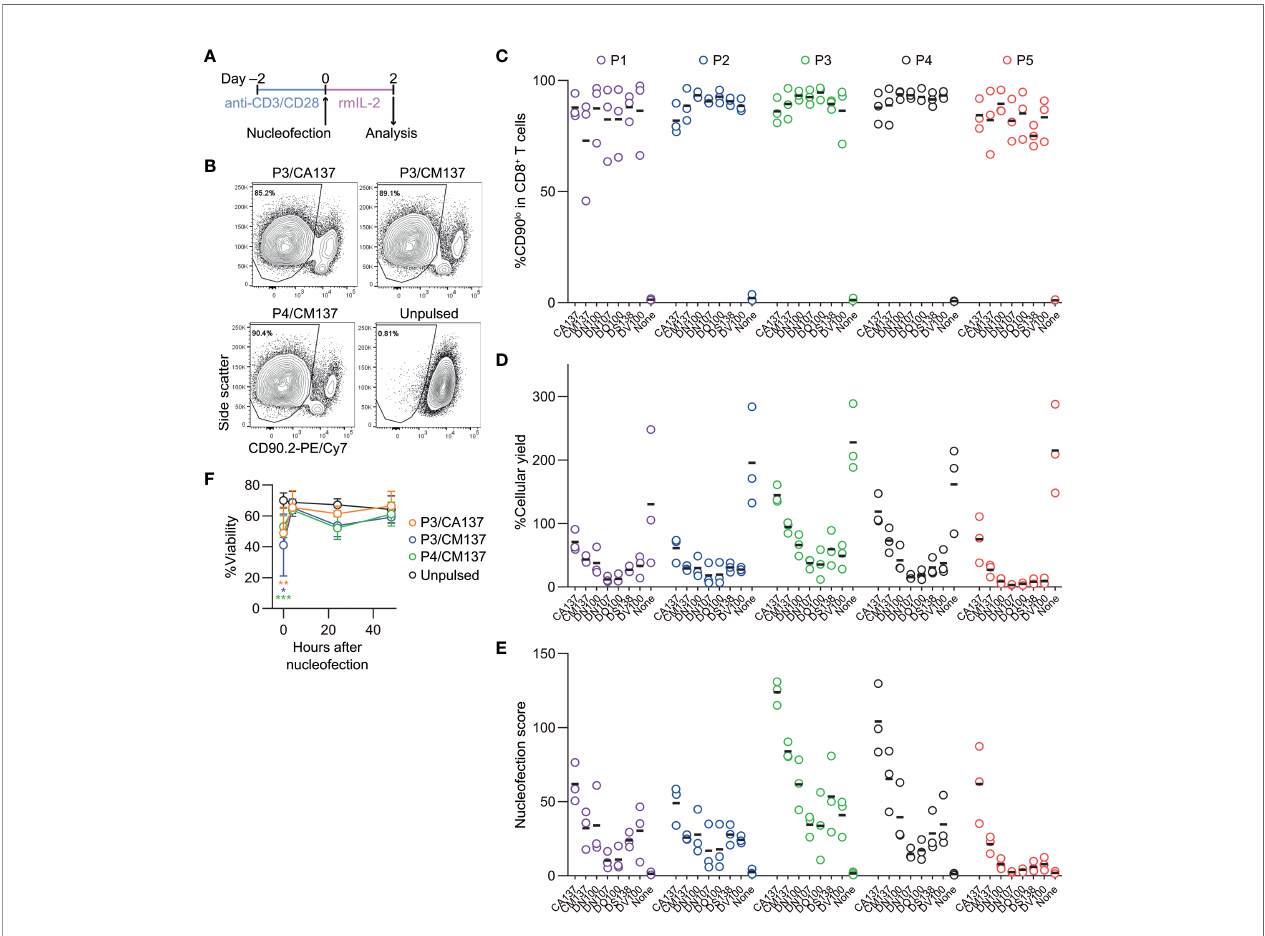
FIGURE 1 | Assessment of knockout ef fi cacy and cellular yield after CRISPR/Cas9 genetic engineering of in vitro -activated CD8 + T cells using nucleofection. (A) Experimental procedure. After activation with anti-CD3 ϵ /CD28 antibodies for 2 days, cells were nucleofected with three CD90 crRNAs and then kept in culture in the presence of rmIL-2 for 2 days before analysis. (B) Representative plots from one experiment showing the downregulation of CD90 protein 2 days after nucleofection. Plots are gated on viable CD8 + T cells. (C – D) %CD90.2 lo in viable CD8 + T cells (C) and cellular yield (D) on day 2. (E) Nucleofection score calculated as [%CD90 lo ] × [%Yield]/100. Graphs show pooled data from three independent experiments. (F) Viability of nucleofected and unpulsed control CD8 + T cells at 24 and 48 hours after nucleofection. Graphs show pooled data of n = 5 from four independent experiments. * p < 0.05, ** p < 0.01, *** p < 0.001 as compared to unpulsed control by ordinary two-way ANOVA with Dunnett ’ s multiple comparison. Differences at 24 and 48 hours after nucleofection were statistically non-signi fi